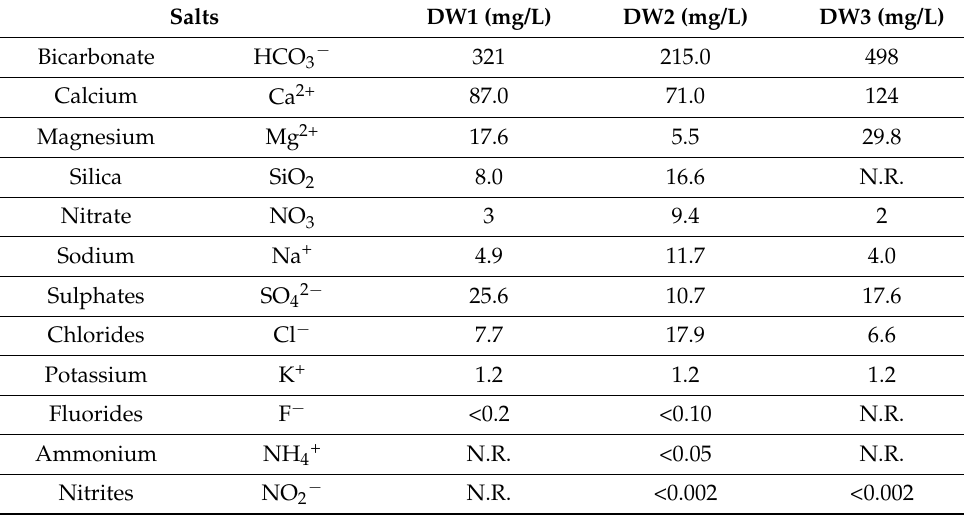
Table 3. Salts composition reported in drinkable water (DW). All the values are considered as mg per liter of water. N.R. = Not